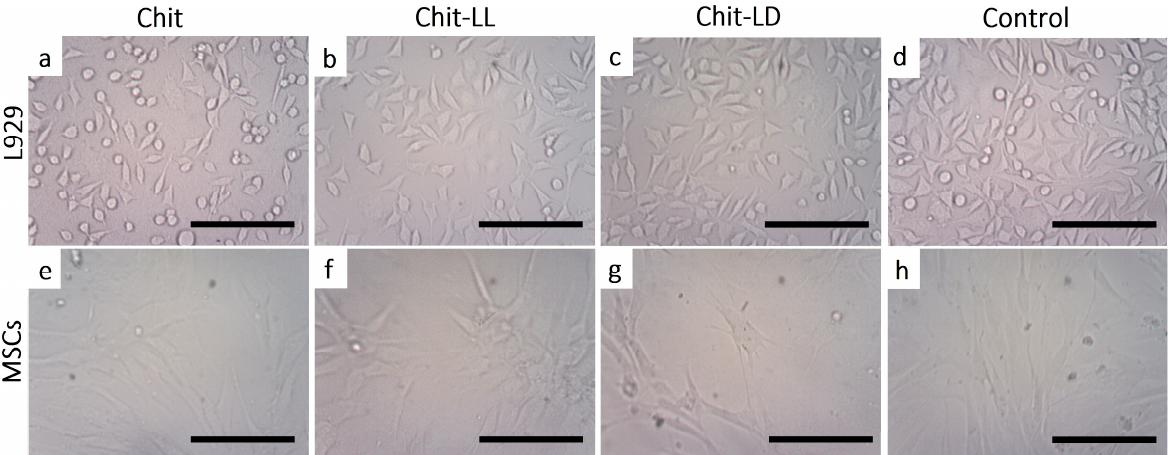
Figure 6. Micrographs of L929 mouse fibroblasts ( a – d ) and mesenchymal stromal cells ( e – h ) on the chitosan (Chit), chitosan-g-oligo(L, L-lactide) (Chit-LL), and chitosan-g-oligo(L, D-lactide) (Chit- LD) films after cultivation for 4 days. Monolayer cell culture ( d , h ) were taken as controls. Optical microscopy. The scale bar is 100 μ m (magnification ×100).